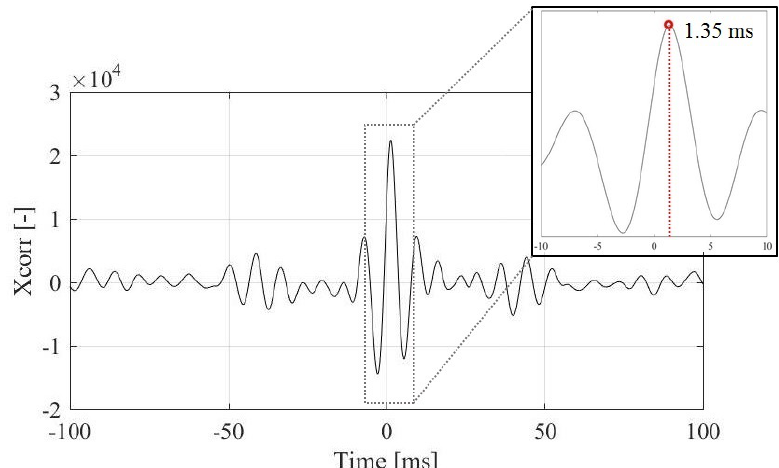
Figure 3. Cross-correlation value of Laser Doppler Vibrometer (LDV) and accelerometer signals. Local maxima at 1.35 ms indicate the accelerometer signal lags behind the LDV signal.